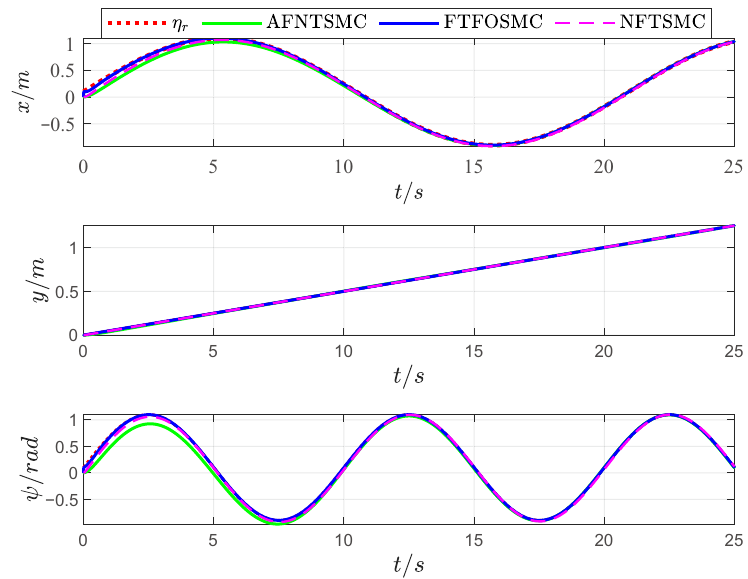
Figure 3. USV trajectory tracking curve in all directions.